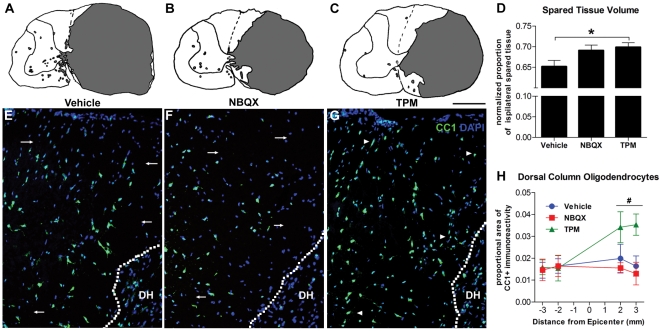
Tissue sparing and oligodendrocyte labeling 48 hrs after severe spinal cord injury.(A–D) Topiramate treated animals had more spared tissue compared to vehicle controls. (A–C) Reprehensive camera Lucida drawing of lesion epicenters from different treatment conditions (lesion area in gray). Notice the increased tissue sparing following topiramate (TPM) and NBQX treatment in the dorsal horn and ventromedial white matter compared to vehicle treated. D) Topiramate and NBQX-treatment increased the average proportional area of tissue spared. Area was quantified over 6 mm centered on the lesion epicenter. E–G) Representative examples of CC1 immunoreactivity in the dorsal columns caudal to the lesion epicenter. Arrows identify areas with no CC1+ cells in vehicle and NBQX conditions (E–F), while arrowheads (in G) identify the same areas with CC1+ cells in the topiramate condition. More CC1 labeling is also evident in the dorsal horn (DH) for topiramate treated animals. H) The density of CC1 immunoreactivity was significant increased with topiramate treatment. *p<0.05; p = 0.07 for NBQX vs. vehicle. #p<0.05 for topiramate vs. vehicle or NBQX for average CC1 density caudal to the lesion epicenter.